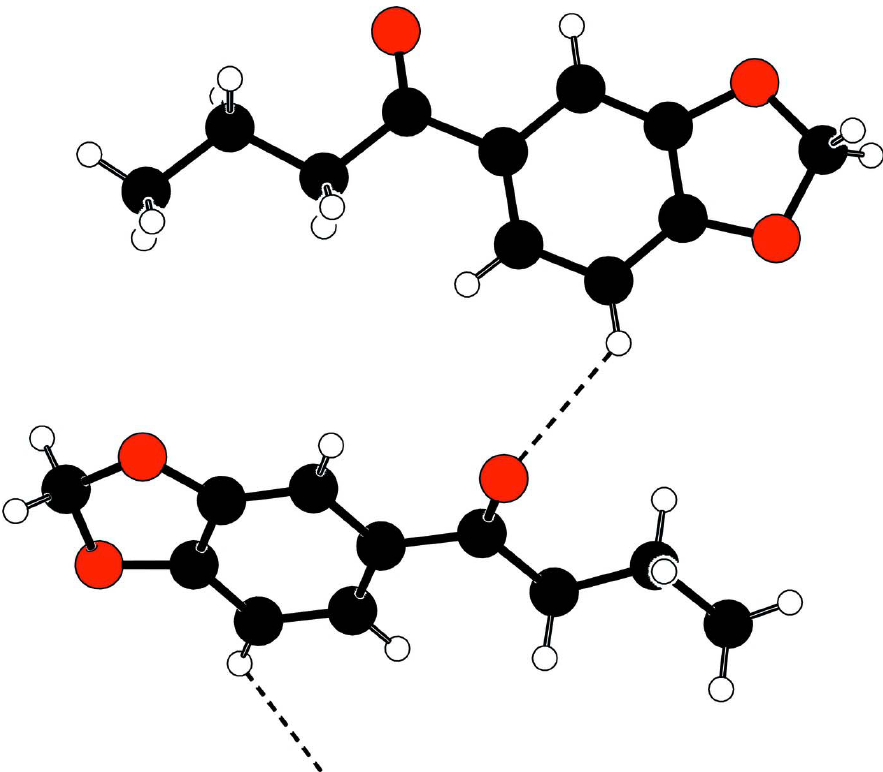
The molecular structure of the title molecule, with the atom-numbering scheme.